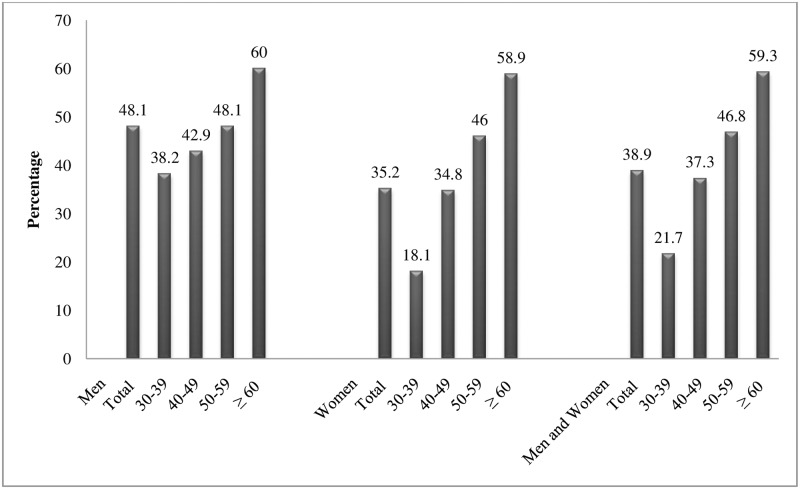
Prevalence of hypertension by sex and age.